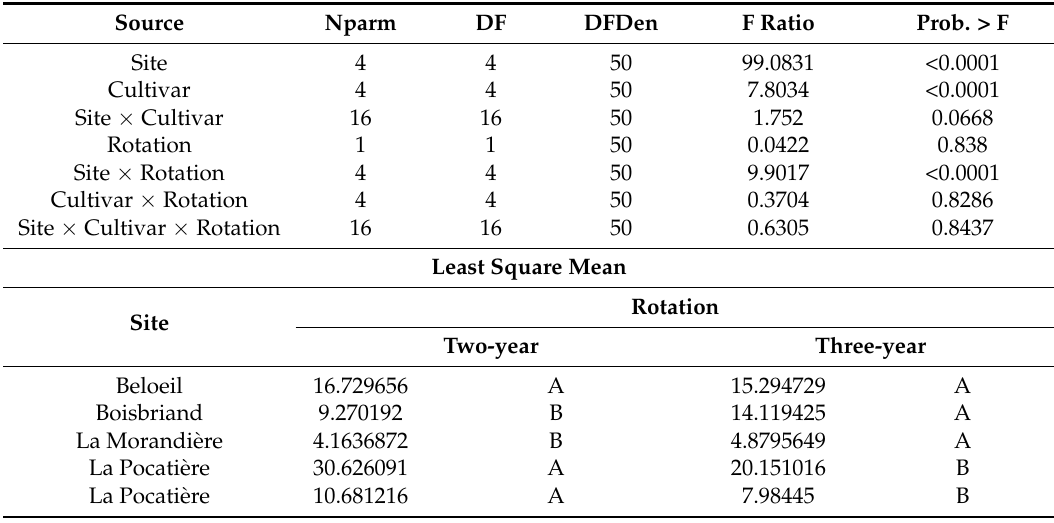
Table 2. Results of ANOVA tests describing the statistical significance of site, cultivar, and rotation on willow biomass